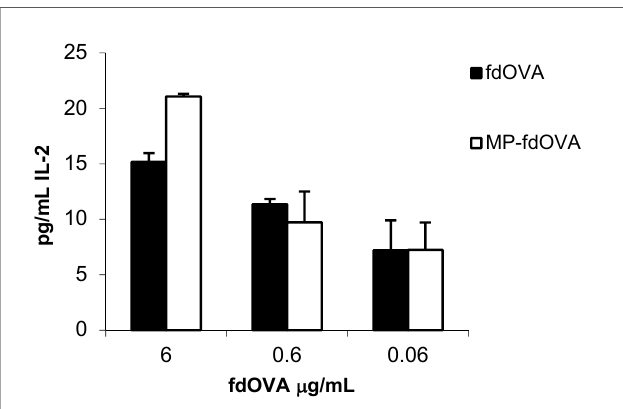
Figure 10. IL-2 release of B3Z hybridoma cell line in response to fdOVA delivering OVA (257–264) SIINFEKL peptide. Bone marrow-derived dendritic cells (BM-DCs) were incubated with graded doses of fdOVA bacteriophage free or released from post-encapsulated MPs. BM-DCs were co-cultured with B3Z hybridoma cells for 40 h and supernatants were assayed in duplicate. Mean + SD is reported, and one representative experiment (of two) is shown. Di ff erences are not significant by Student’s t -test ( p > 0.05).